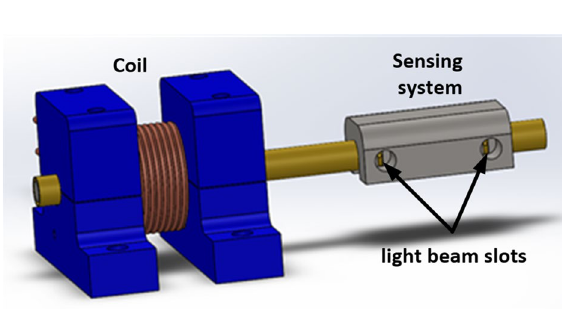
Figure 5. The coil and sensing system schematic illustration.